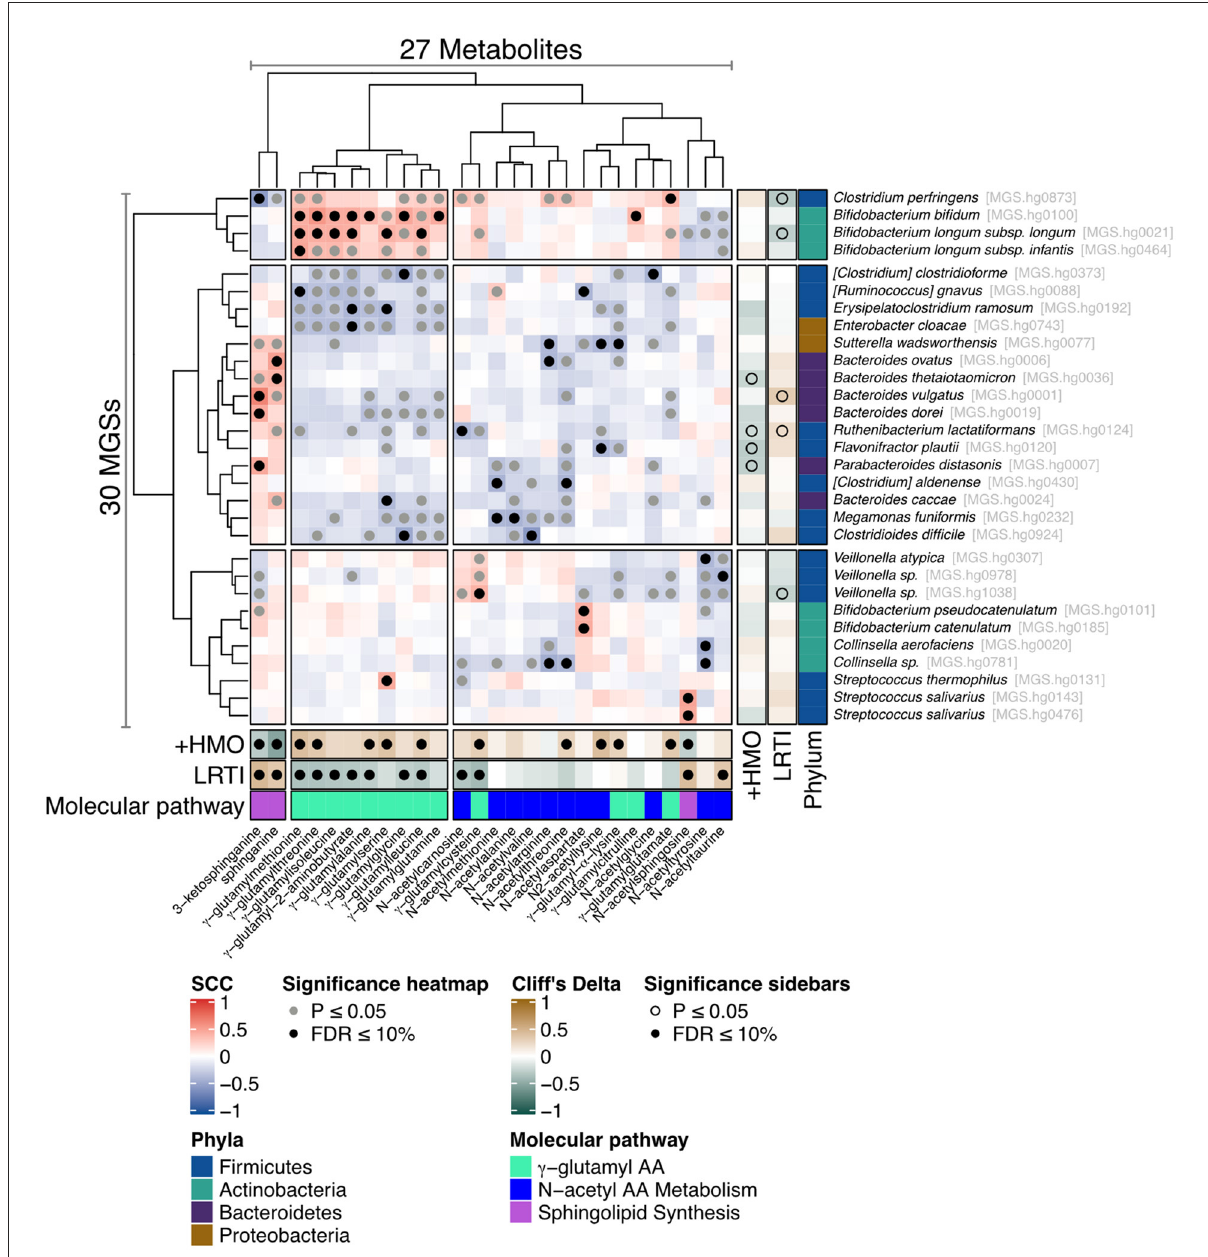
FIGURE2 Heat map illustrating the correlation between metagenomic species (MGSs) and stool metabolites. Association map of the three-tiered analyses integrating the phenome, the gut microbiome, and the stool metabolome in the 80 formula-fed infants with available metabolomics data. The main “heat map” panel shows SCC between MGSs and the stool metabolites. Statistically significant correlations are indicated with filled gray (Spearman’s correlation p ≤ 0.05) or black (Spearman’s correlation FDR ≤ 0.1) circles. The right and bottom “sidebar” panels show associations between the same MGSs and metabolites, respectively, and feeding group ( + HMO for the 2-HMO feeding group) or incidence of LRTI. The colors indicate the direction and magnitude of the association (Cliff’s Delta), where brown means the MGS or metabolite is more abundant in 2-HMO-fed infants or in infants who experienced one or more episodes of LRTI, and green means the MGS or metabolite is more abundant in control-fed infants or in infants who did not experience an LRTI episode.